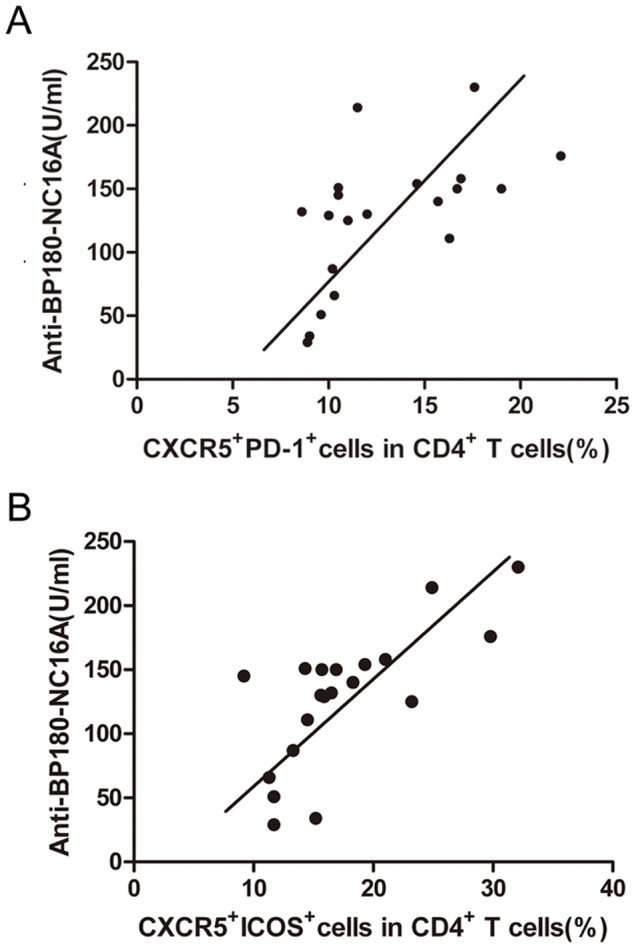
The correlation between the percentage of Tfh cells and the anti-BP180-NC16A autoantibody titers in the peripheral blood of BP patients.(A) The correlation between the percentages of CXCR5+PD-1+ cells among the CD4+ T lymphocytes and the anti-BP180-NC16A autoantibody titers of 20 BP patients. (B) The correlation between the percentage of CXCR5+ICOS+ cells among the CD4+ T lymphocytes and the anti-BP180-NC16A autoantibody titers of 20 BP patients. Each data point represents an individual subject.